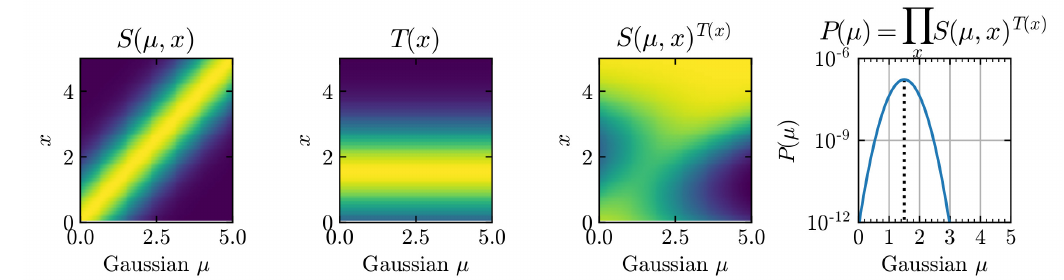
Figure 16. If the full probability density is known (shown in the left panel), the parameter of an unknown sample (second panel) can be obtained by maximizing the likelihood. The third panel shows the probability of observing each element in the unknown set, T . The final panel shown the total probability, obtained by taking the product of the individual probabilities, and is maximized at the true underlying